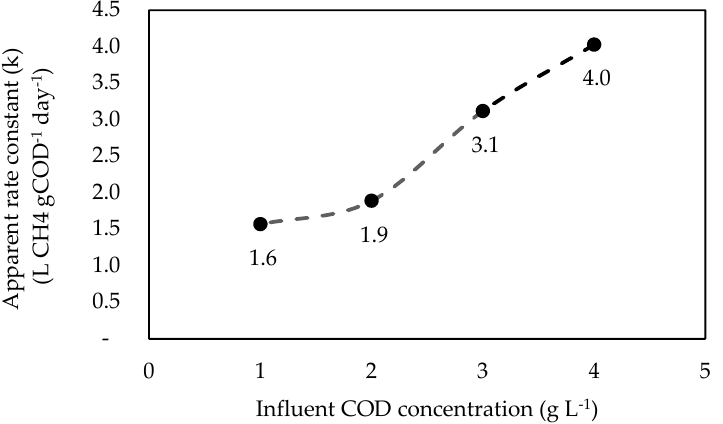
Figure 8. Relationship between apparent rate constant ( K ) and influent substrate concentration. The result was comparable to the result obtained by Zinatizadeh et al. [27], which presented the highest K value of 7.4 L CH 4 g − 1 COD day − 1 at a high feeding COD concen- tration. This phenomenon might be due to the high specific activity of microorganisms inside the reactor. The hybrid system (biofilm or attached microorganism) applied inside the MAHB reactor allowed to metabolize the intermediate products, such as VFA. The apparent rate constant ( K ) was further interrelated with the concentration of microorgan- isms ( X ) (in terms of VSS), as shown in Figure 9. The experimental data fitted well with an R 2 value of 0.89. However, in contrast with 𝐾 = (cid:4674) Y M µ m (cid:3026) (cid:3294) (cid:3012) (cid:3294) X , a nonzero intercept was observed. This condition might be due to the inability to distinguish other suspended organic matter, as well as true microorganisms.